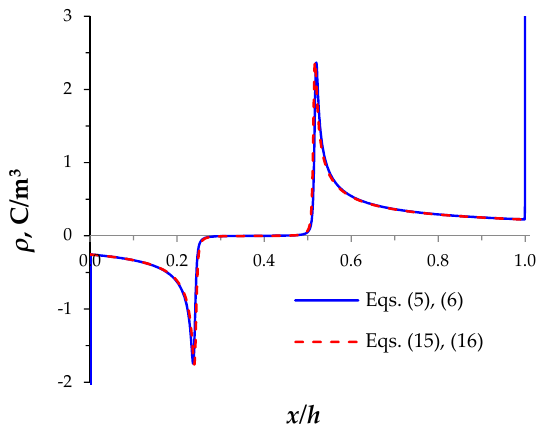
Figure 6. Distribution of the space charge density, ρ , at t = 24 s calculated with Equations (5) and (6) (solid line) or with Equations (15) and (16) (dashed line) for c 0 = 0.001 mol/m 3 , T 2C = T 1A = 0.03, i = 2 i lim . Conditions (15) and (16) made it possible to calculate the model for the electrolyte concentration c 0 = 2 mol/m 3 with sufficient accuracy (the difference between the average (cid:3035) total current density in the channel, 1 ℎ⁄ (cid:1516) (𝑖 (cid:3007) + 𝑖 (cid:3030) )𝑑𝑥 , and the specified current density, (cid:2868)